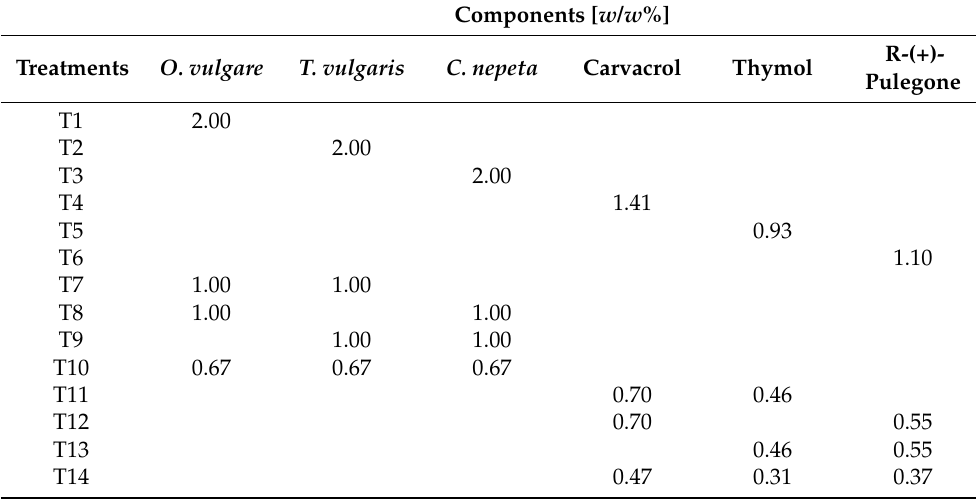
Table 2. Chemical compositions and concentrations of EOs and APs present in each